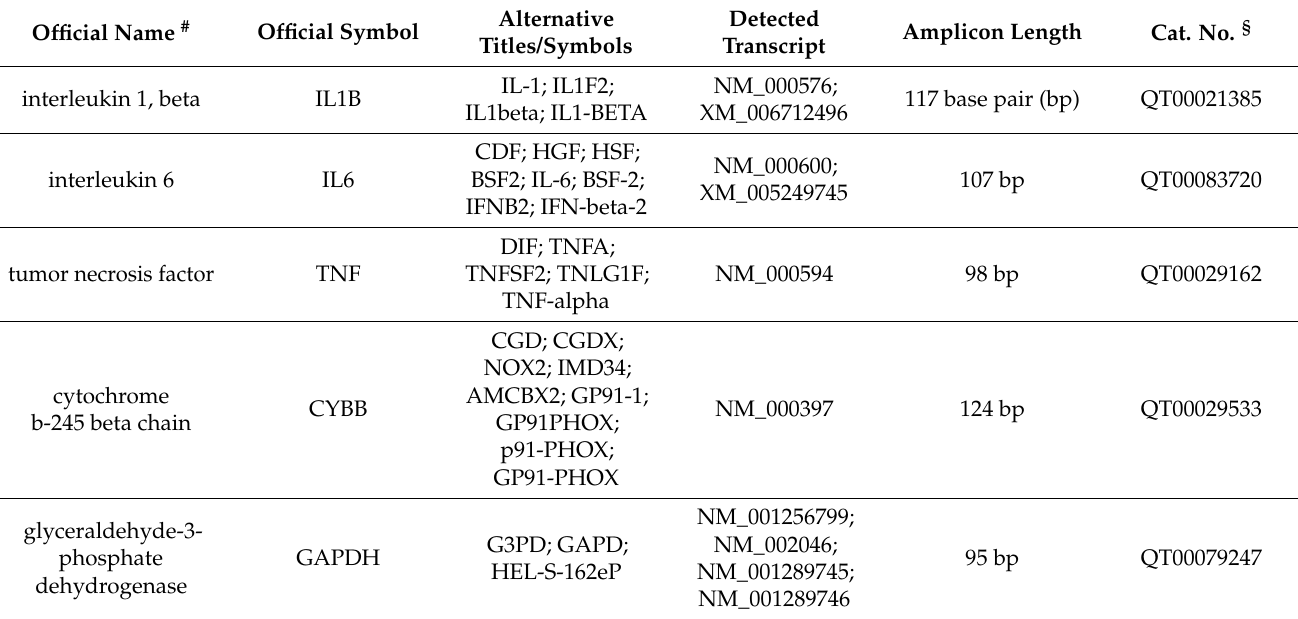
Table 1. The list of primers used for